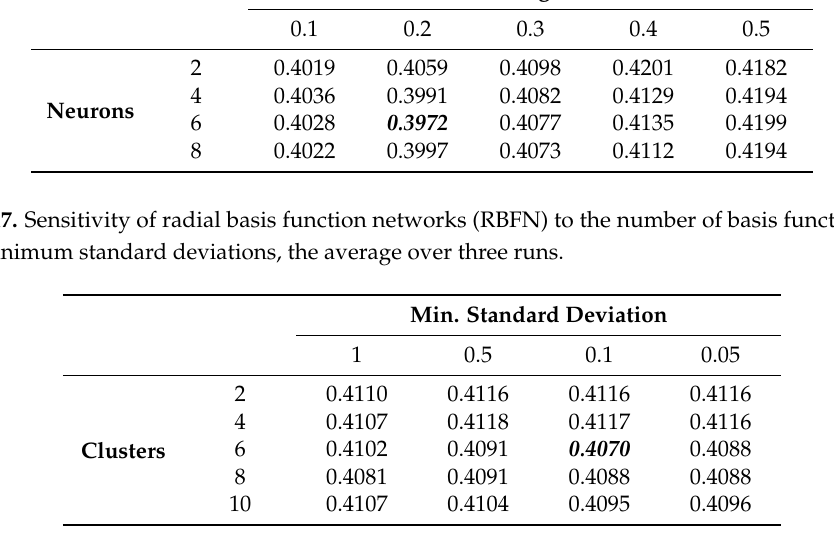
Table A8. Sensitivity of support vector machines trained with sequential minimal optimization (SMO-Reg) to the complexity and the epsilon parameter of the loss function used by the optimizer, the average over three